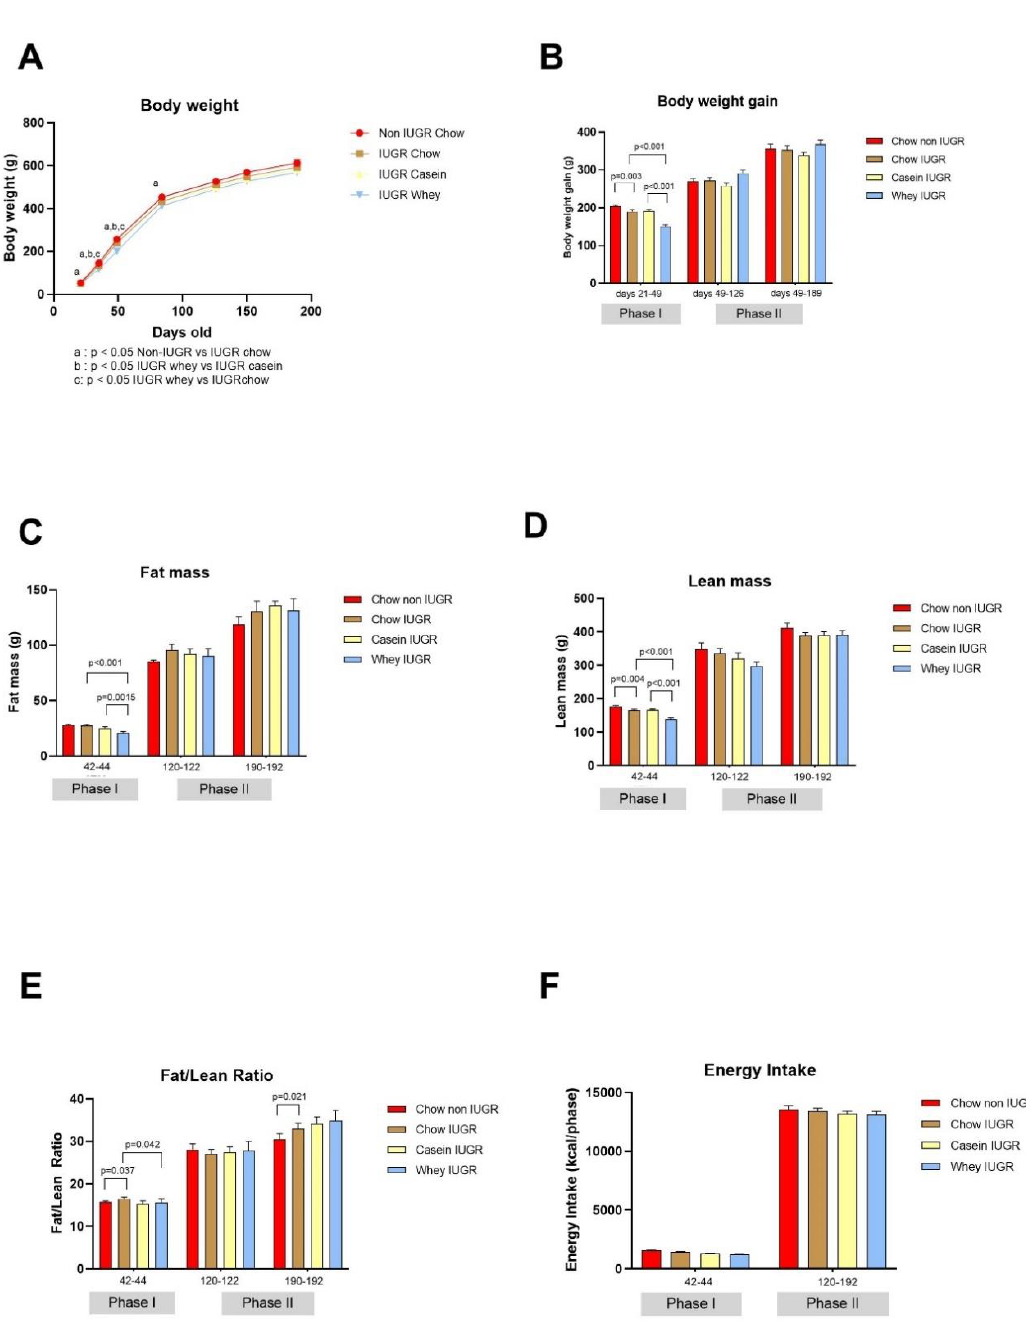
Figure 3. Body weight, body composition, and energy intake. ( A ) Body weight in grams of each group ( n = 19 chow non-IUGR; n = 20 chow IUGR; n = 20 casein IUGR; n = 19 whey IUGR); values are mean ± SEM; ( B ) Body weight gain in grams per phase of the study ( n = 19–20 all Phases), values are mean ± SEM; ( C ) Fat mass in grams for each group ( n = 19 chow non-IUGR; n = 20 chow IUGR; n = 20 casein IUGR; n = 19 whey IUGR), values are median ± SE median; ( D ) Lean mass in grams for each group ( n = 19 chow non-IUGR; n = 20 chow IUGR; n = 20 casein IUGR; n = 19 whey IUGR), values are median ± SE median; ( E ) Fat / lean ratio for each group ( n = 19 chow non-IUGR; n = 20 chow IUGR; n = 20 casein IUGR; n = 19 whey IUGR); ( F ) Energy intake (kcal / phase) n = 19–20 in each phase, values are mean ± SEM.